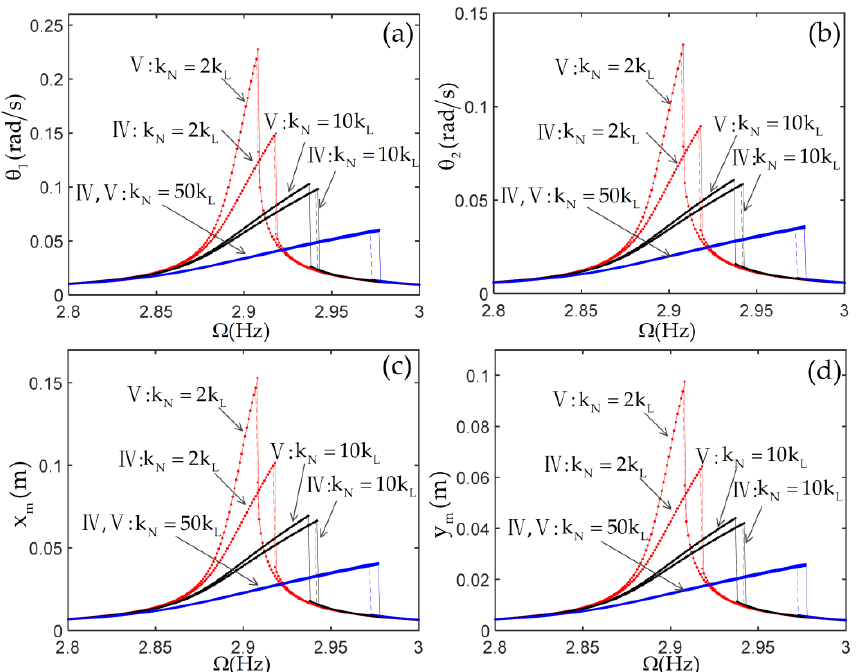
Figure 10. The frequency response curves of the structure with first joint; ( b ) the displacement of second joint; ( c ) the horizontal displacement of tip mass; ( d ) the vertical displacement of tip mass;